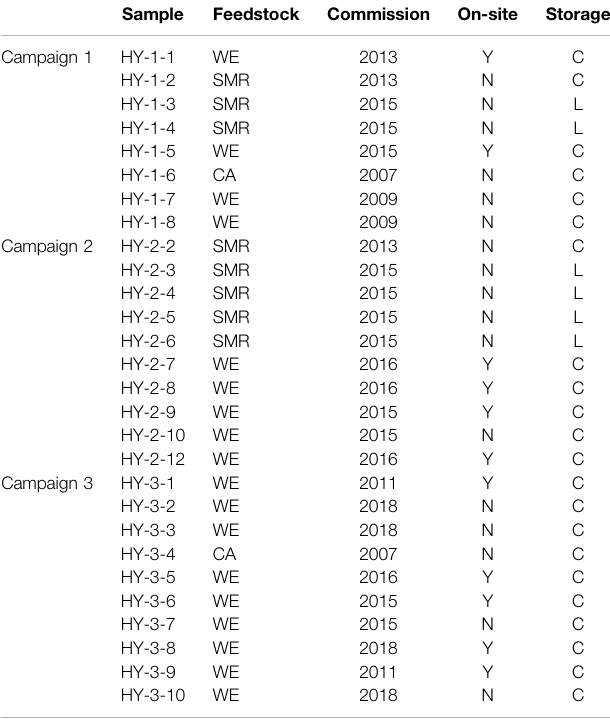
TABLE 2 | List of HRS from which samples were collected.